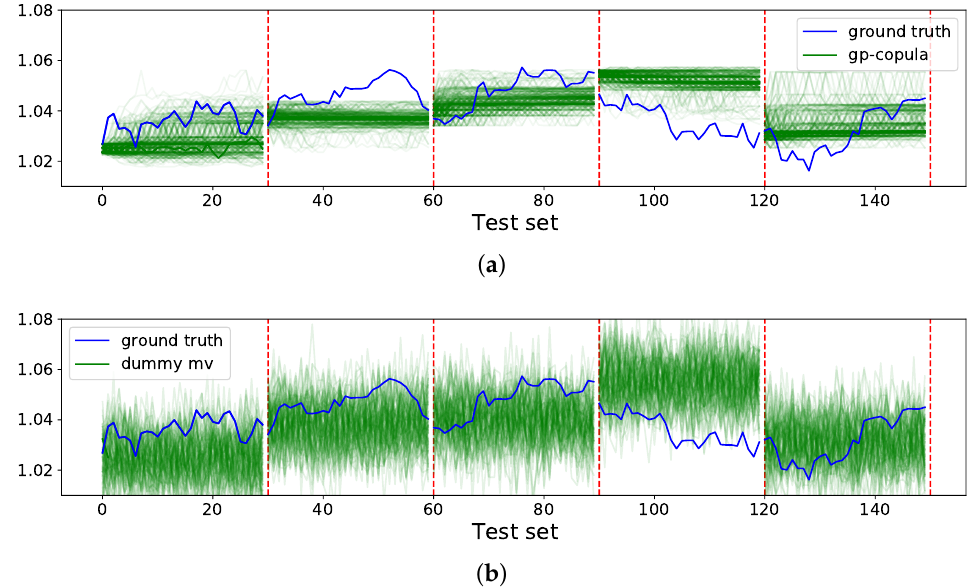
Figure 3. These figures illustrate the 400 forecast samples from GP-copula and dummy multivariate model for the first dimension of the exchange-rate dataset, alongside the expected ground truth. While dummy multivariate model forecasts look like random noise as expected, it is hard to spot any meaningful pattern in GP-copula forecasts in comparison to the expected value. ( a ) Visualization of GP-copula samples. ( b ) Visualization of forecast samples from dummy multivariate